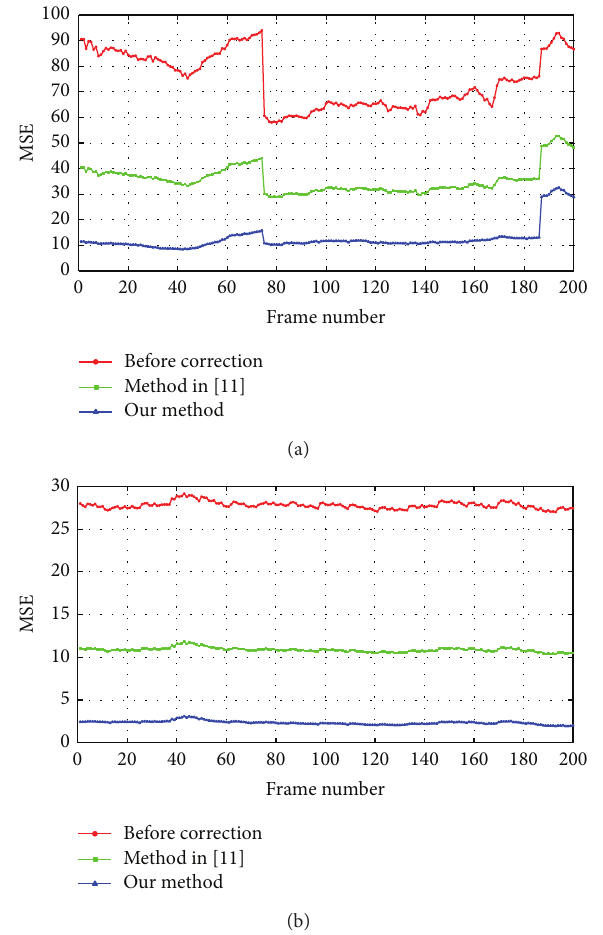
Figure 8: MSE versus frames in “Fireman” and “Lotus.”